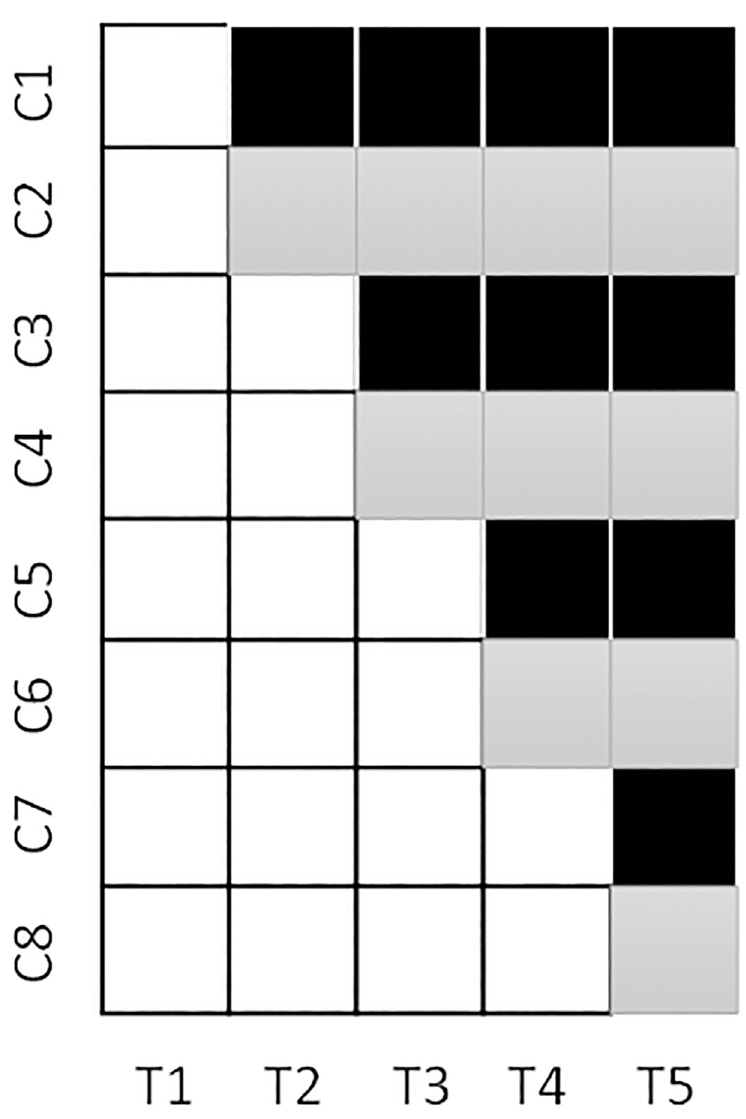
Fig 3. 3-group, concurrent, disinvestment trial. White = current service condition, Black = no service condition, Grey = alternate service condition.